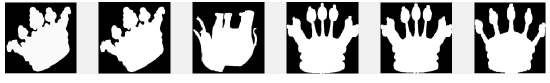
Figure 14. Qualitative results of DCA fusion of SCF with